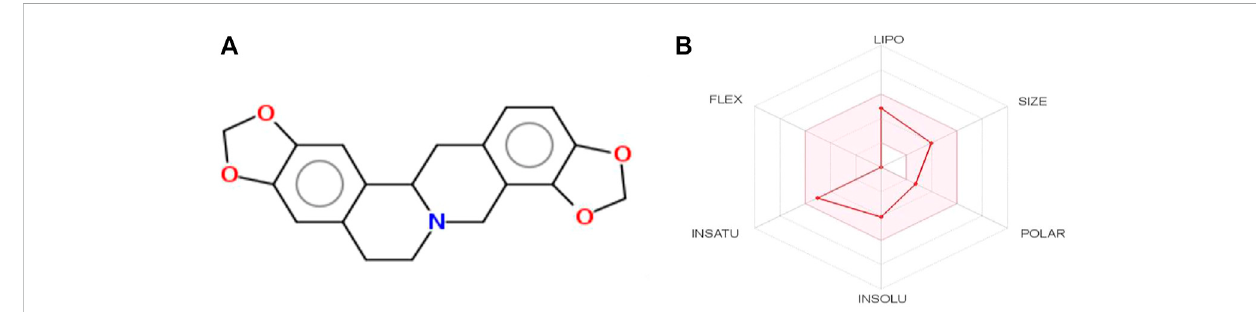
FIGURE 2 (A) Two-dimensional (2D) structure of stylopine; (B) Bioavailability graphical RADAR plot of stylopine using SwissADME web-based